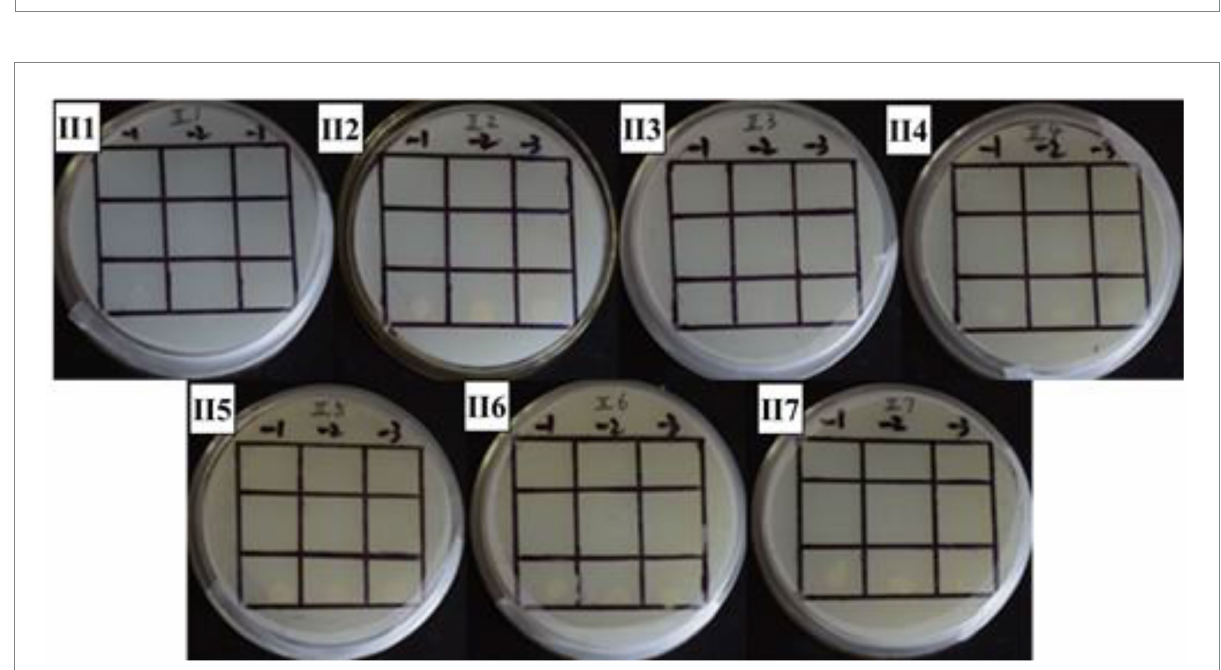
FIGURE 6 Positive sieve plate with 1 mM 3’AT, 0 μ g/ml NaNO 2 (II1), 20 μ g/ml NaNO 2 (II2), 40 μ g/ml NaNO 2 (II3), and 60 μ g/ml NaNO 2 (II4)80 μ g/ml NaNO 2 (II5), 100 μ g/ml NaNO 2 (II6) and 120 μ g/ml NaNO 2 (II7). The first row: US0/pH3U3; the second row: US0/pH3U3-pNir; the second row: US1/pH3U3-pNir. − 1, − 2, and − 3 indicate that the three columns of point samples from left to right are 10 − 1 , 10 − 2 and 10 − 3 in the figure of gradually reducing concentrations of bacterial solution mixed with